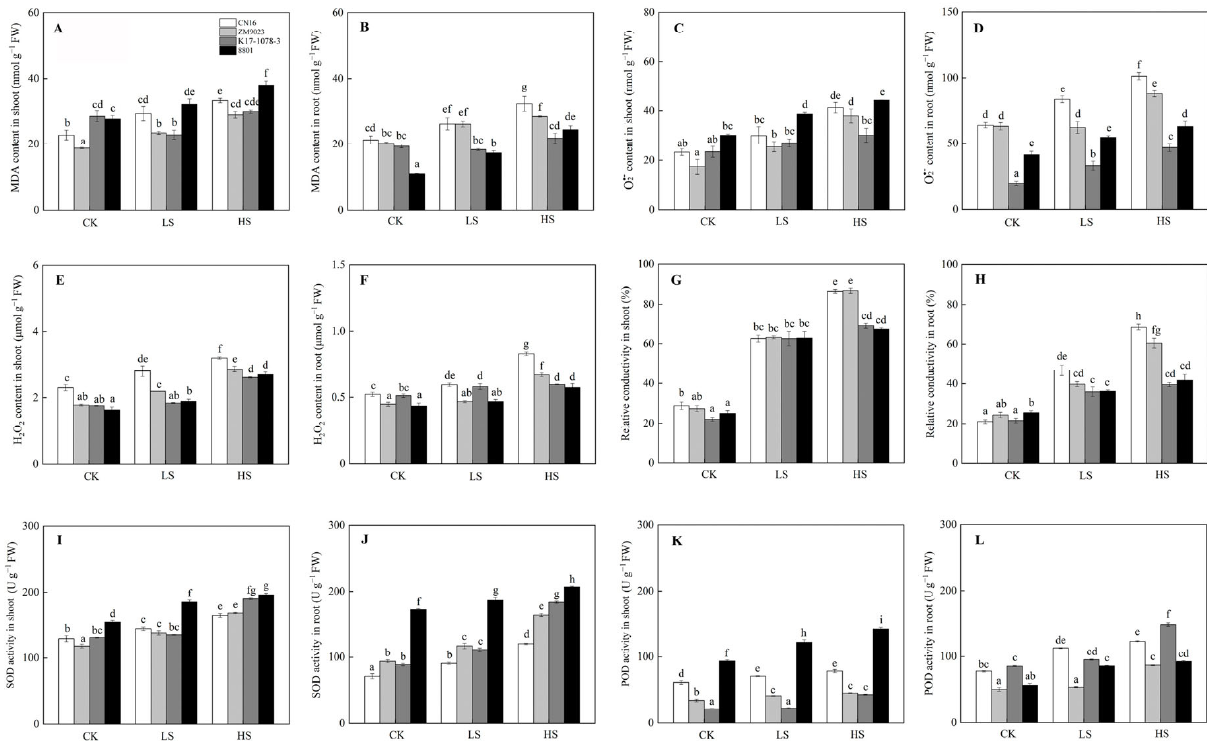
Figure 5. The MDA content in shoot ( A ) and root ( B ); O 2 •− content in shoot ( C ) and root ( D ); H 2 O 2 content in shoot ( E ) and root ( F ); relative conductivity in shoot ( G ) and root ( H ); SOD activity in shoot ( I ) and root ( J ); and POD activity in shoot ( K ) and root ( L ) variations of K17-1078-3 and its parents subjected to different salinity levels. Different letters indicated significant difference due to salt treatments according to Duncan’s multiple range tests. CK, LS, and HS referred to NaCl concentrations of 0, 50, and 200 mM.